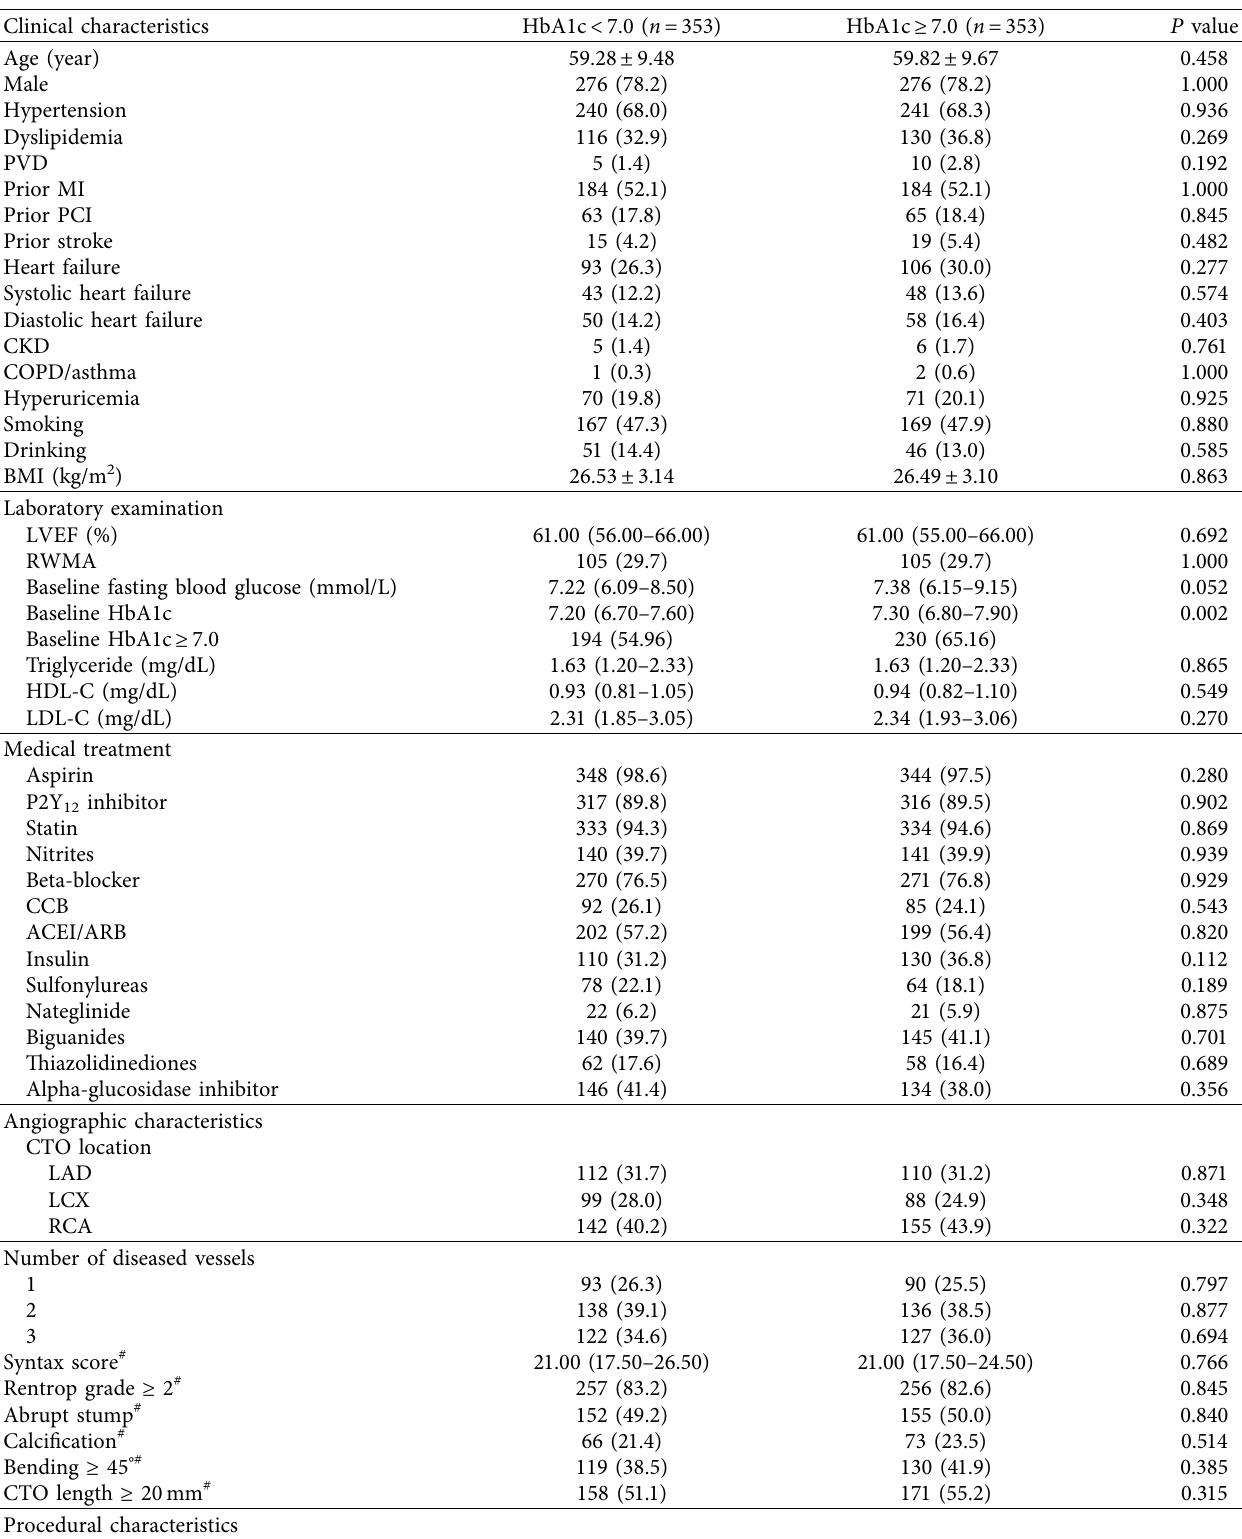
Table 2: Baseline characteristics in propensity score-matched population. Clinical